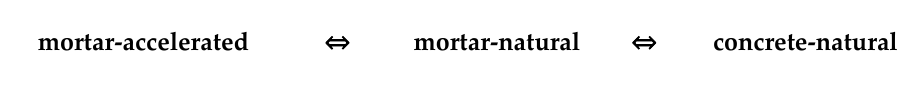
Figure 12. Sequence of k coefficient correlations.